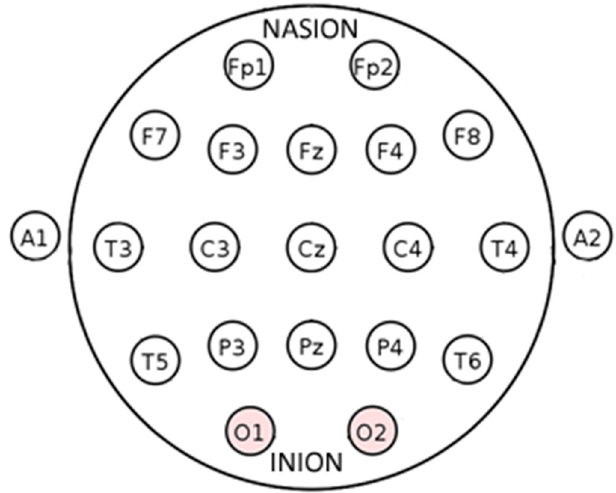
Figure 3. Electrode locations of International 10–20 system for EEG (electroencephalography) recording. Fp1, Fp2, F7, …, T6, O1, O2 are points for electrode placement.